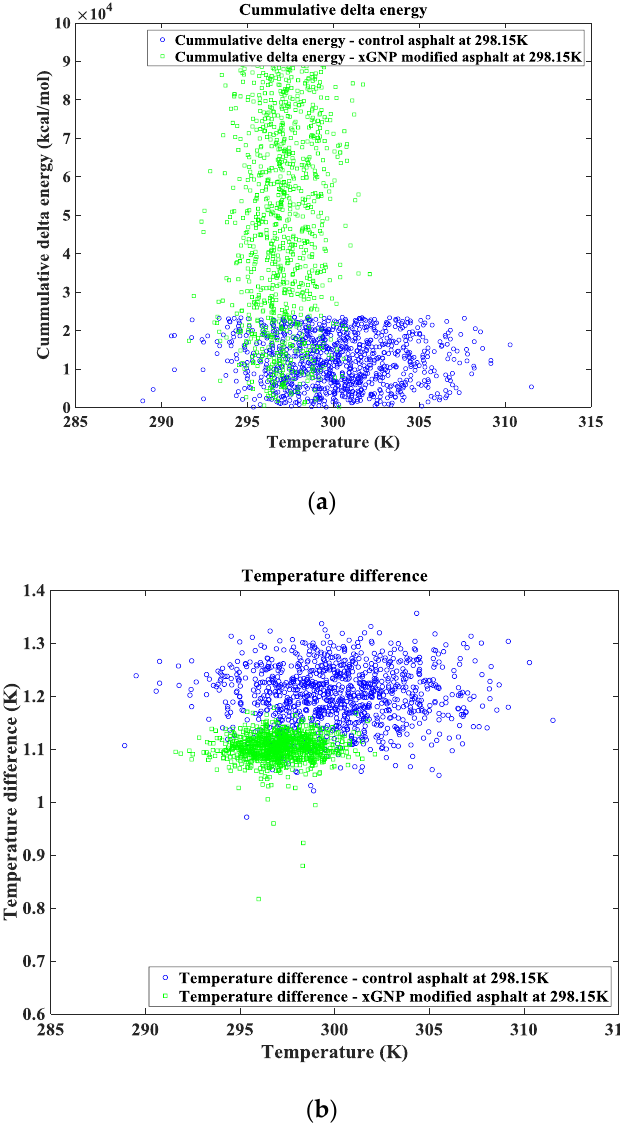
Figure 10. Thermal conductivity calculations in the MD simulations. ( a ) Cumulative delta energies of the control and xGNP modified asphalt binder systems at a temperature of 298.15 K; ( b ) Temperature difference of the control and xGNP modified asphalt binder systems at a temperature of 298.15 K.